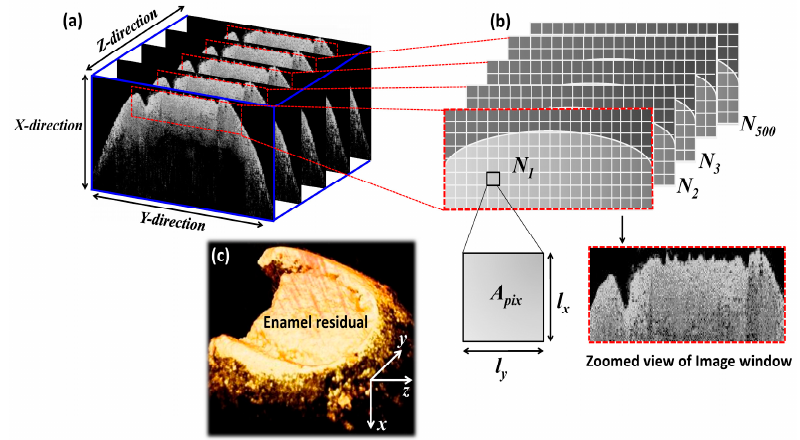
Figure 2. Volumetric evaluation algorithm for enamel residual. ( a ) Sequential 2D OCT images along with the applied image window; ( b ) Detected pixels, which satisfy the applied pre-determined threshold range; ( c ) Acquired 3D OCT volumetric image.